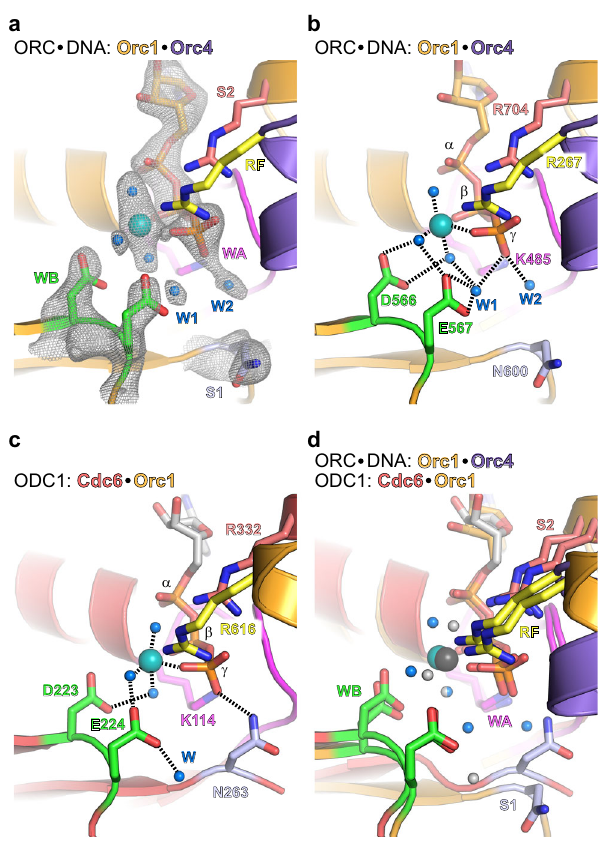
Fig. 2 The ATPase sites reside in a pre-hydrolysis state. a and b Con fi guration of the Orc1·Orc4 ATPase site in DNA-bound Sc ORC. The density-modi fi ed cryo-EM map is shown as gray mesh for ATP, Mg 2 + , waters, and Walker B and sensor 1 side chains in a . c Con fi guration of the Cdc6·Orc1 ATPase site in ODC1. Dashed lines in b and c summarize bonding interactions of water molecules and sensor 1. Superposition of the Orc1·Orc4 and Cdc6·Orc1 ATPase sites of Sc ORC·DNA and Sc ORC·DNA·Cdc6, respectively, highlights the different conformations of the sensor 1 residues. Magnesium and waters are shown in teal and blue, respectively; an exception is the Orc1·Cdc6 site in ( d ), where the corresponding elements are colored gray. See also Supplementary Fig.